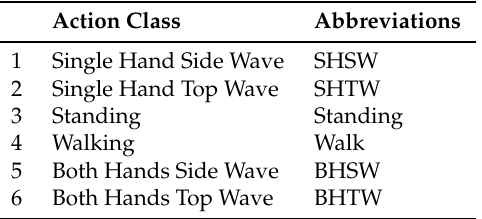
Table 1. Action Class labels with